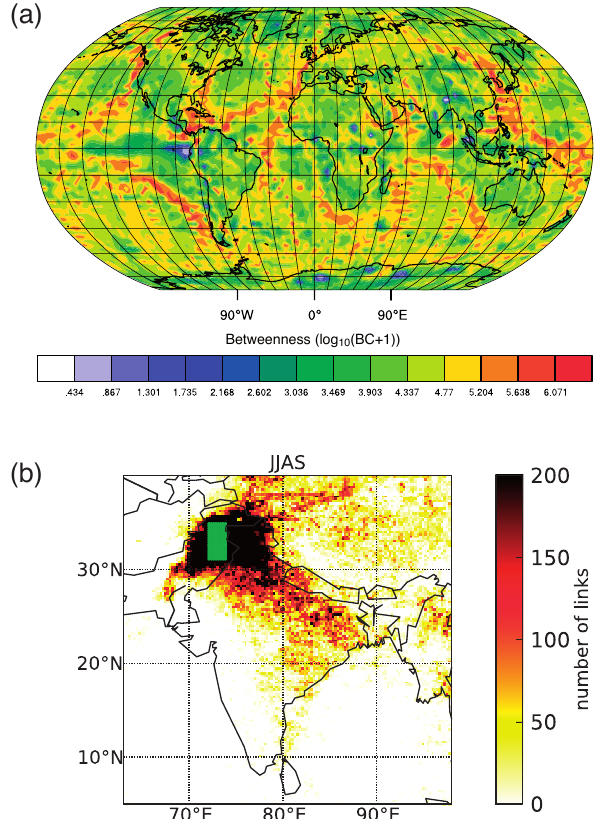
Figure 1. (a) Network visualisation colour-coding scalar node mea- sures (shortest path betweenness) on the map to study spatiotempo- ral relations of the surface air temperature field (Python/PyNGL, reprinted from Donges et al., 2009a). (b) Visualisation high- lighting the location of network edges by colouring the number of edges starting in a selected region (green box) of the map (Python/matplotlib.basemap, reprinted from Stolbova et al.,